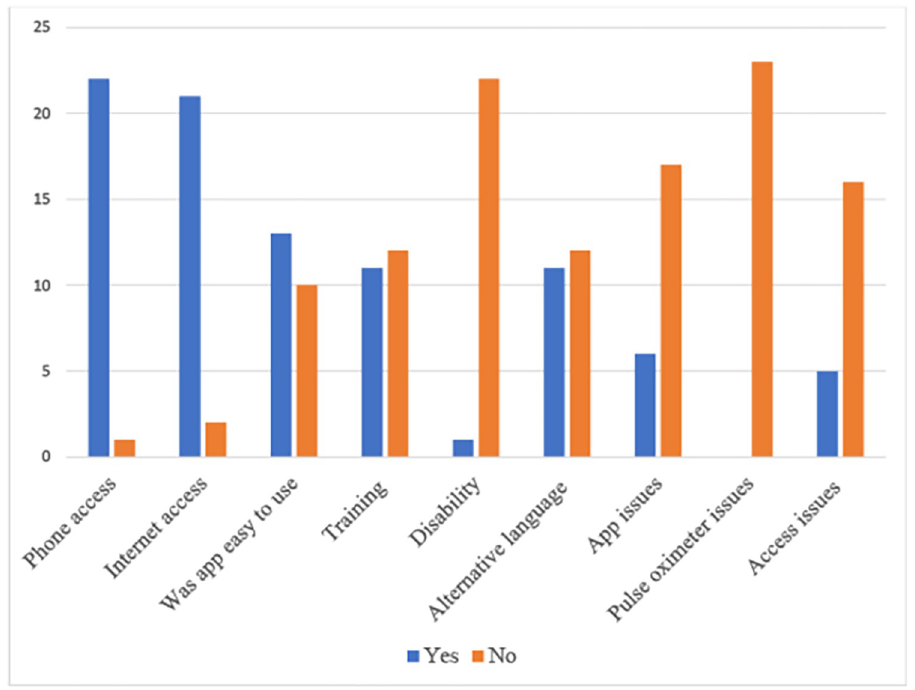
Fig 1. Graphical representation of the non-app users answers to questions 5–9 (detailed in S2 Index).